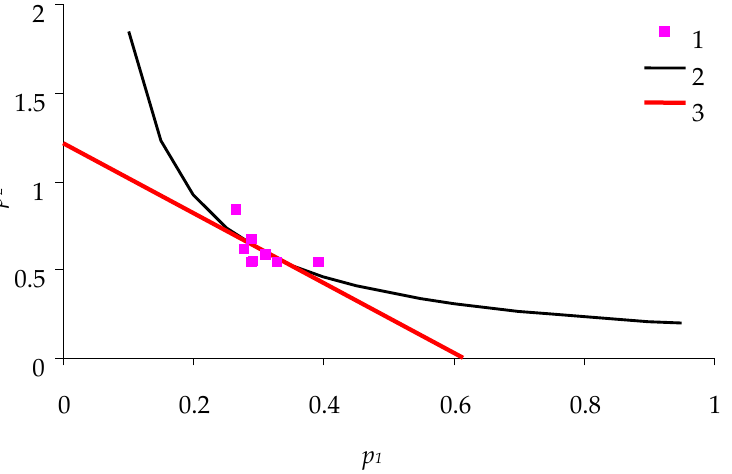
Figure 3. The energy balance of spongy moth females on birch: (1) characteristics ( p 1 , p 2 ) of individual caterpillars; (2) efficiency curve q = p 1 × p 2 ; (3) line of budgetary constraints on feed consumption.